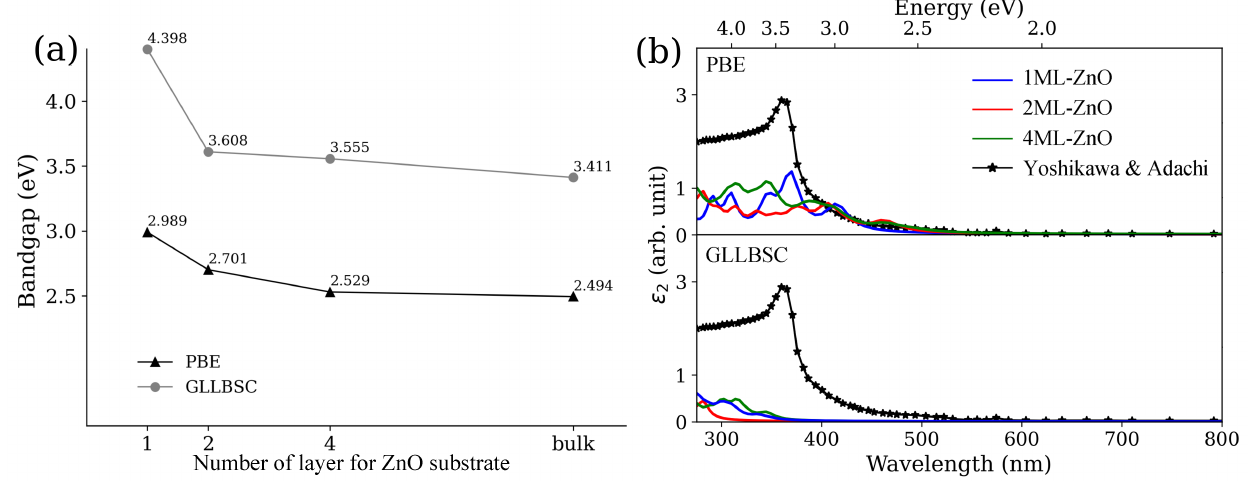
Figure 3. Band gap ( a ) and imaginary part of dielectric function ( ε 2 ) ( b ) of 1ML-, 2ML-, and 4ML-ZnO substrates calculated by means of PBE and GLLBSC E XC s. The upper panel in ( b ) shows ε 2 calculated by means of PBE E XC , while the bottom panel shows ε 2 calculated by means of GLLBSC E XC . The experimental ε 2 graph of bulk ZnO has been reported by Yoshikawa and Adachi elsewhere